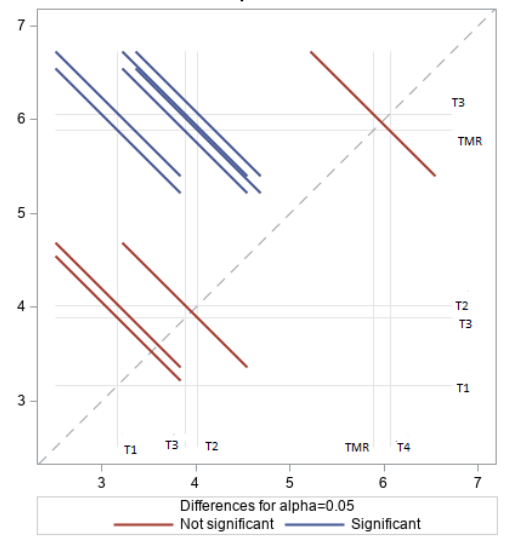
Figure 3. Effect of treatments on n-6/n-3 % content of longissimus dorsi (LD) fat muscle in Naemi Figure 3. E ff ect of treatments on n-6 / n-3 % content of longissimus dorsi (LD) fat muscle in Naemi lambs.